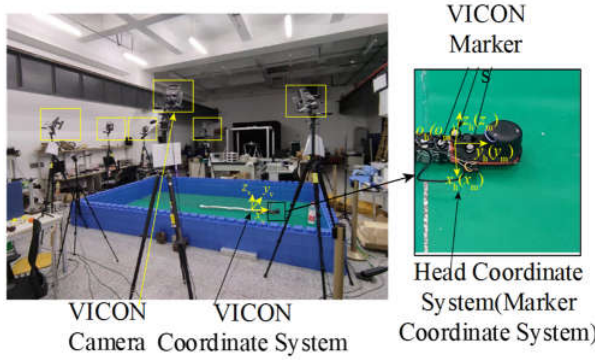
Figure 13. VICON system and coordinate system definition.